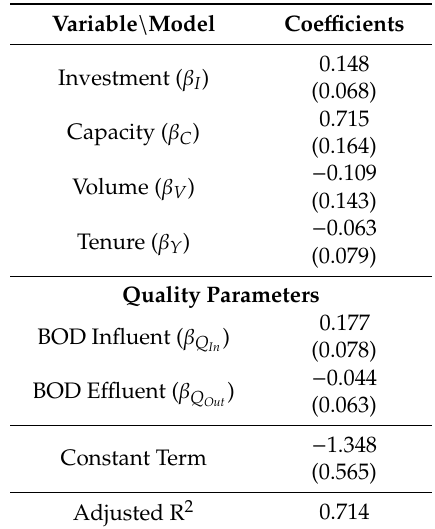
Table A4. Constant elasticity functional form without climate variables (used for